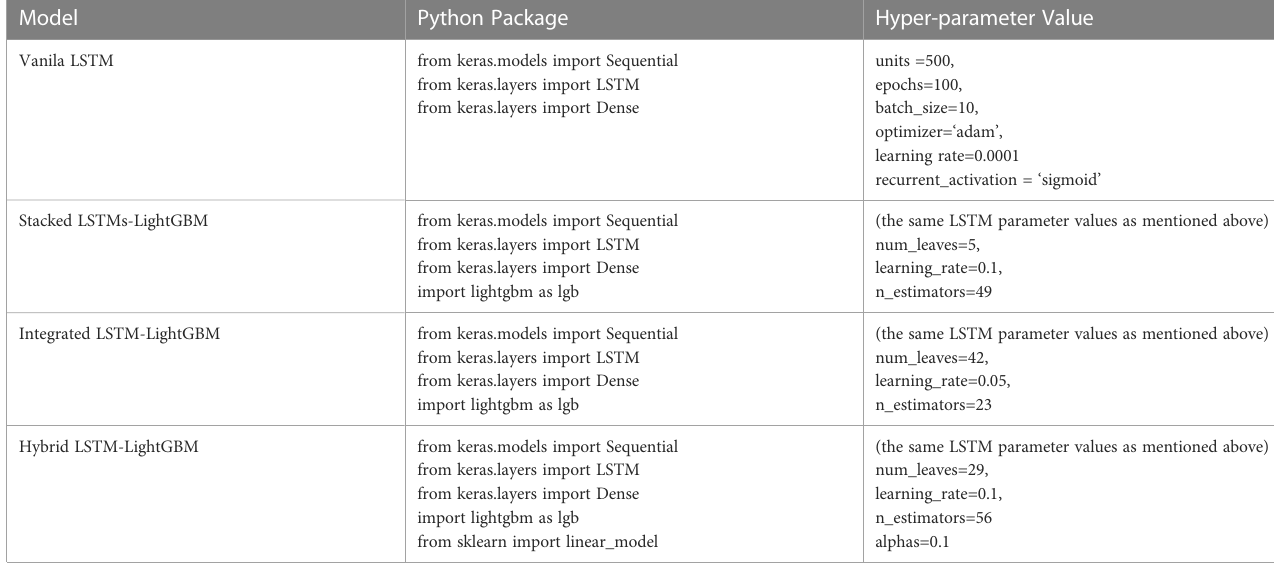
TABLE 3 The parameter values for different